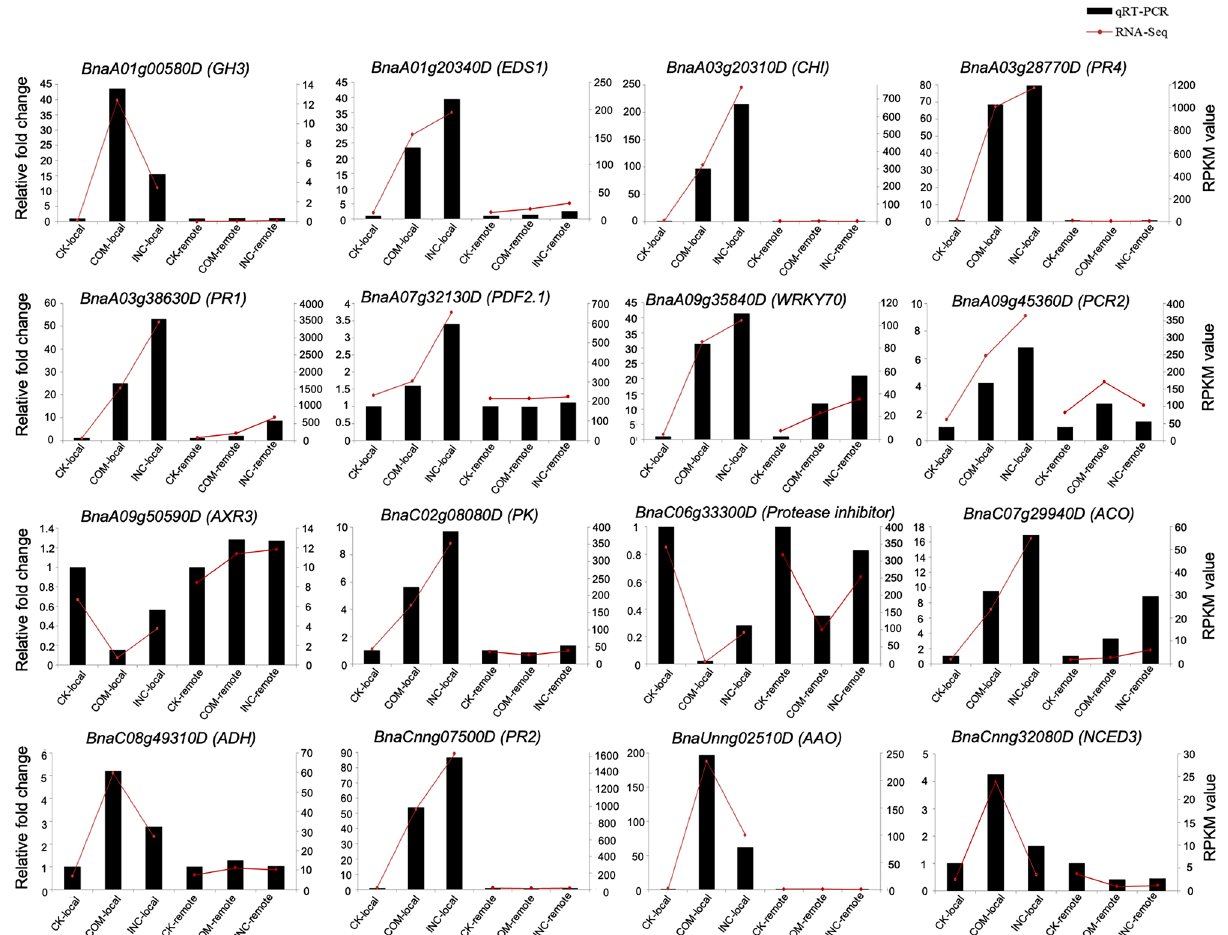
Figure 8. Expression profile of selected DEGs in RNA-seq and qRT-PCR analyses. Red lines indicate the transcript abundance of RNA-seq (right y-axis) based on RPKM, while black bars represent the relative expression level against the average value of mock (CK-local or CK-remote) in